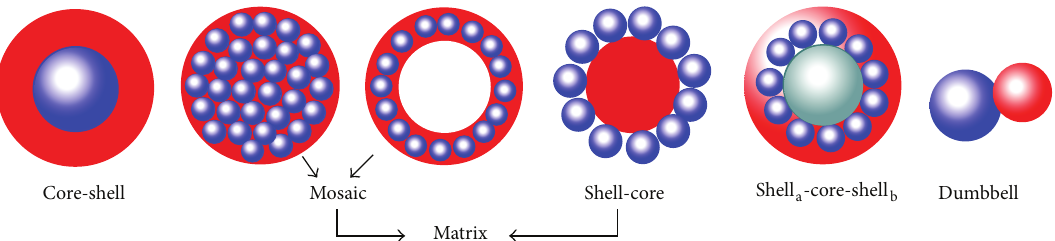
Figure 16: The schematic of some possible structures of inorganic coatings such as core-shell, matrix (mosaic), shell-core, and shell-core-shell structures